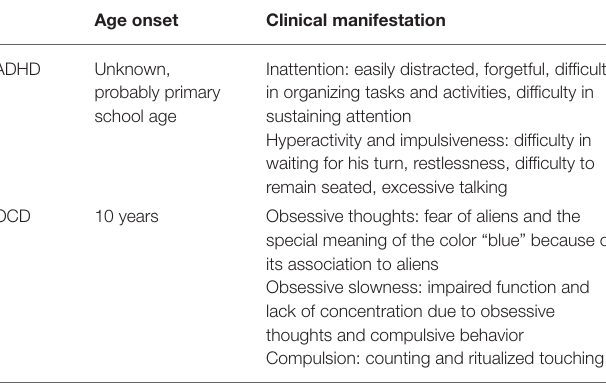
TABLE 1 | Summary of the clinical manifestations of ADHD and